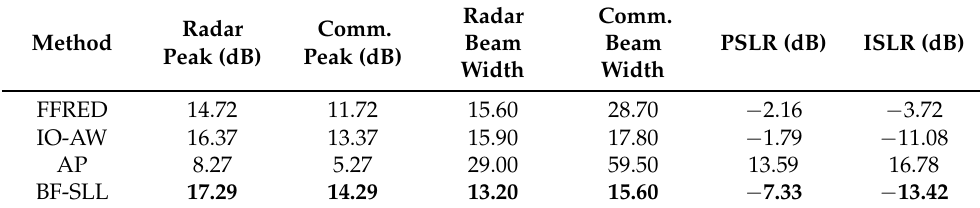
Figure 3. Transmit beampattern comparison for different methods. Table 2. Results of the beampattern performance